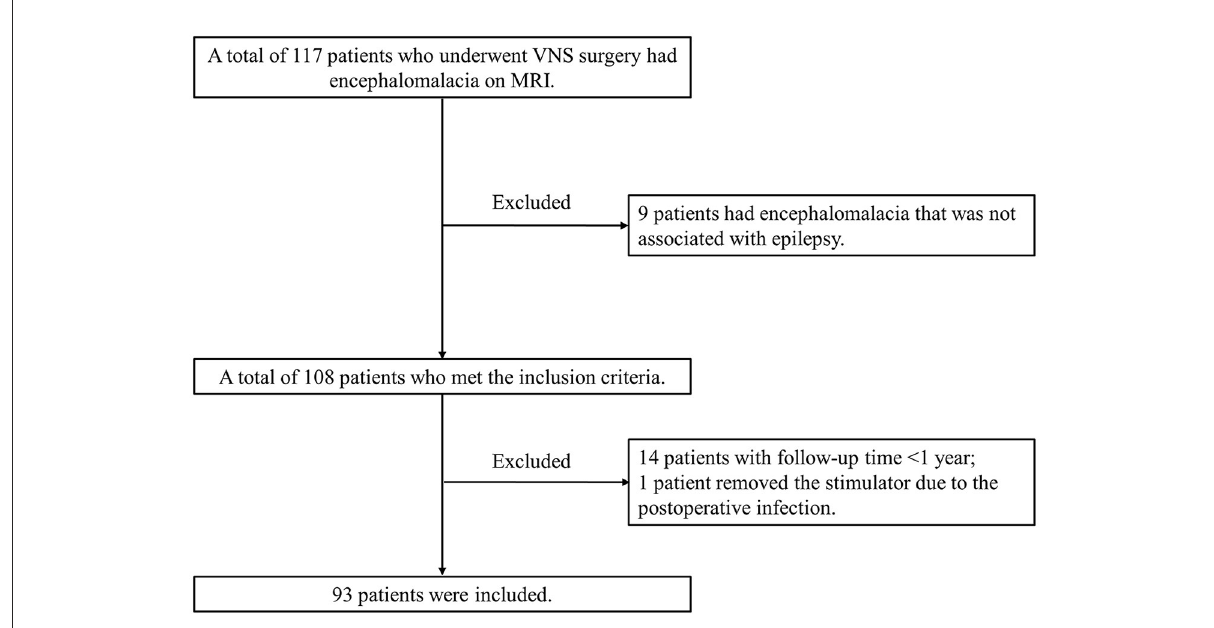
FIGURE1 Flowchart for recruiting patients who satisfy the inclusion and exclusion